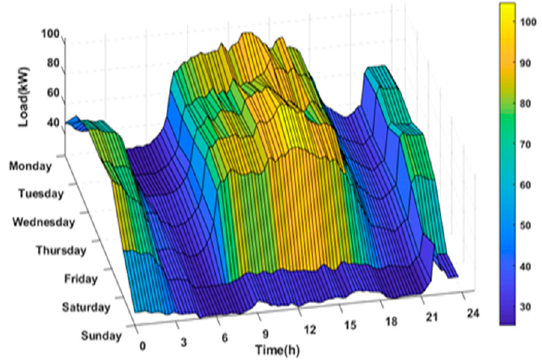
Figure 15. Korean Electric Power Company (KEPCO) substation demand load profile.